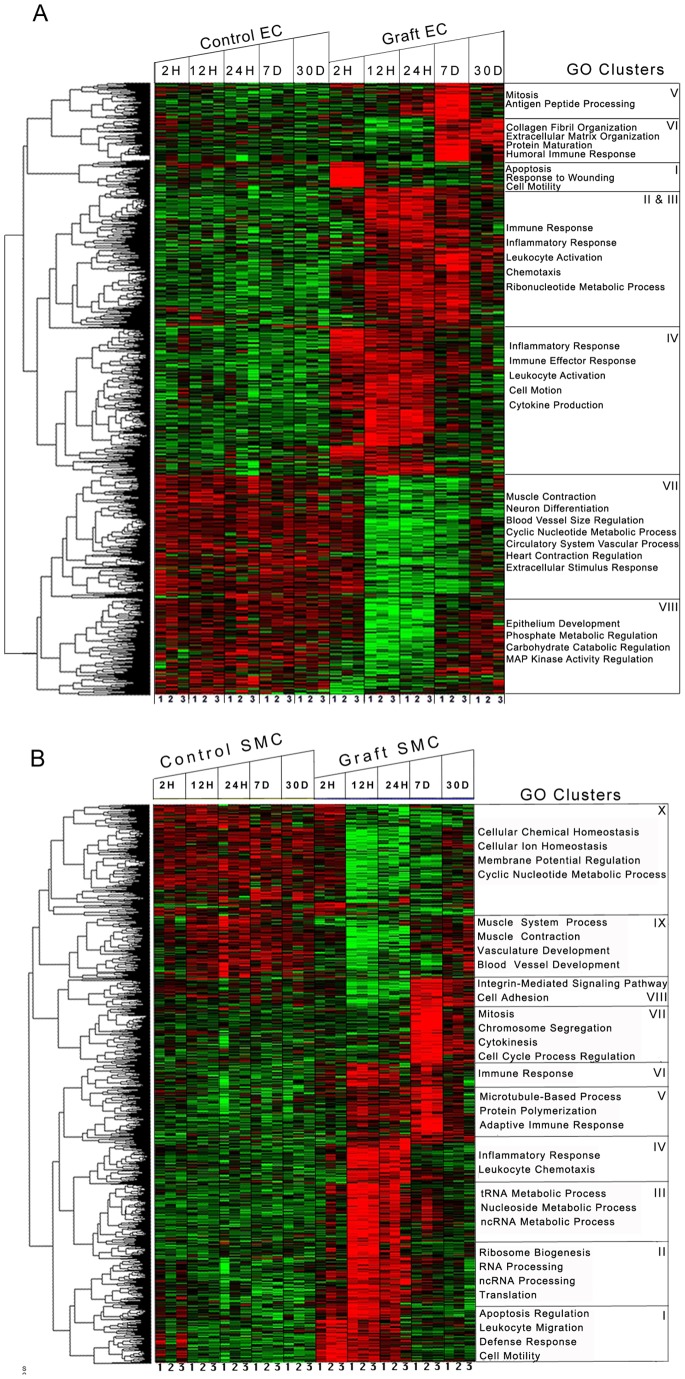
Time series analysis of differentially expressed genes following vein graft implantation. A) EC, B) SMC:The columns represent samples and the rows represent genes. Gene expression is shown with a pseudocolor scale (−1 to 1) with red color denoting increase and green color denoting decrease in gene expression. The heatmaps depict the differential gene expression patterns of endothelial cells (EC) and smooth muscle cells (SMC) that are clustered using K means. The gene ontology categories enriched in each K means cluster are represented with heatmaps. The detailed patterns of gene expression are provided for EC and SMC in Figures S3A & S3B respectively.